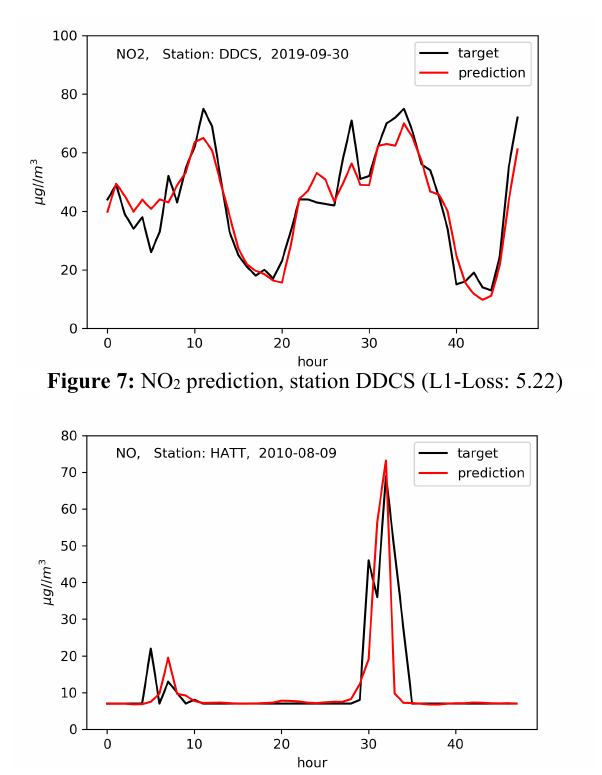
Figure 8: NO prediction, station HATT (L1-Loss: 3.12)